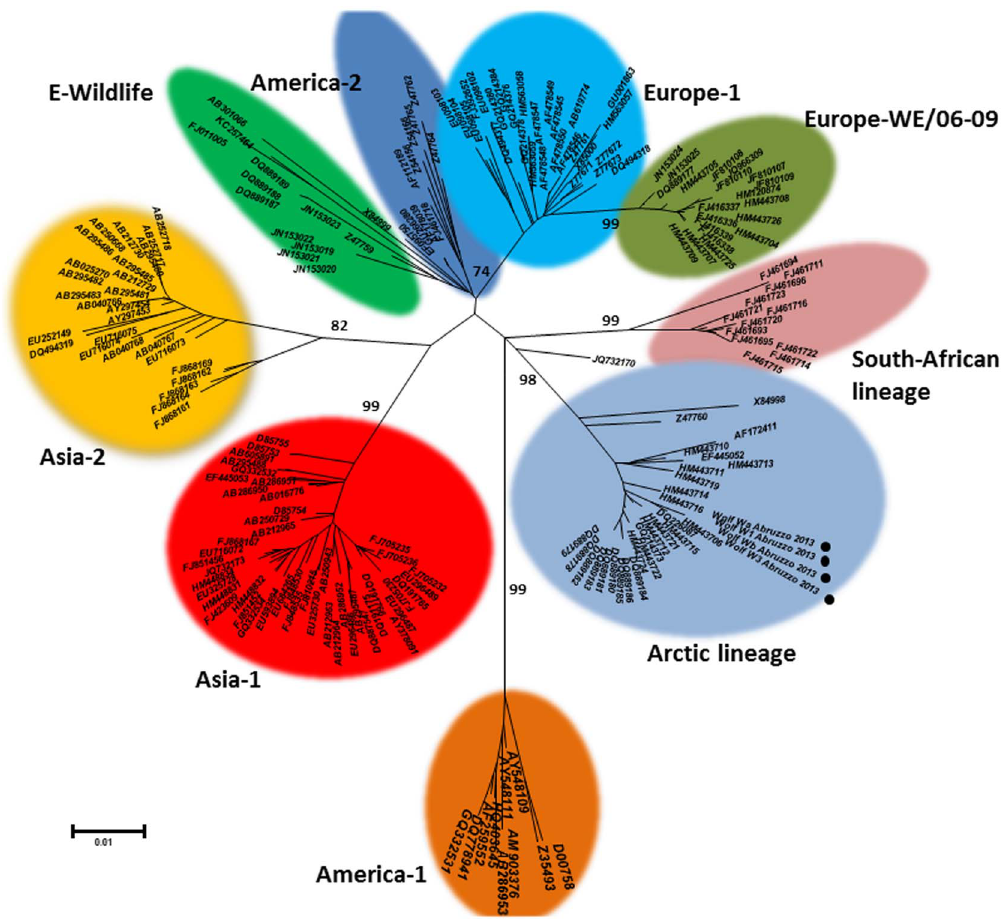
Figure 5. Neighbour-joining tree inferred from multiple nucleotide sequence alignment of the H encoding gene of selected CDV strains retrieved from GenBank. Sequences obtained in this study are marked with a circle.